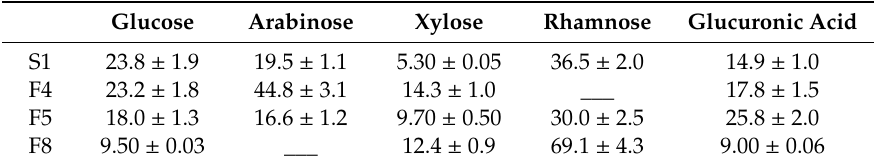
Table 6. Molar sugar content, as detected by HPLC, of the biologically active fractions along with the hydrolysate and the mother algal